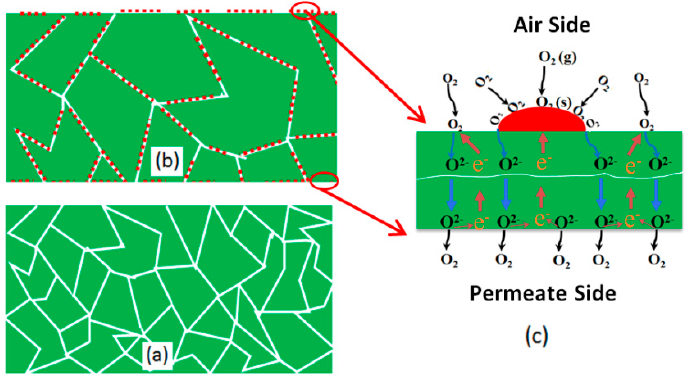
Figure 6. Effects of silver catalyst distribution on the ionic transport through LCF membrane for oxygen permeation ( a ) pure LCF without Ag; ( b ) LCFA; ( c ) inset showing the oxygen permeation behavior. Green area: LCF; red dots: Ag particles; and white lines: grain boundary area of the sintered LCF particles.